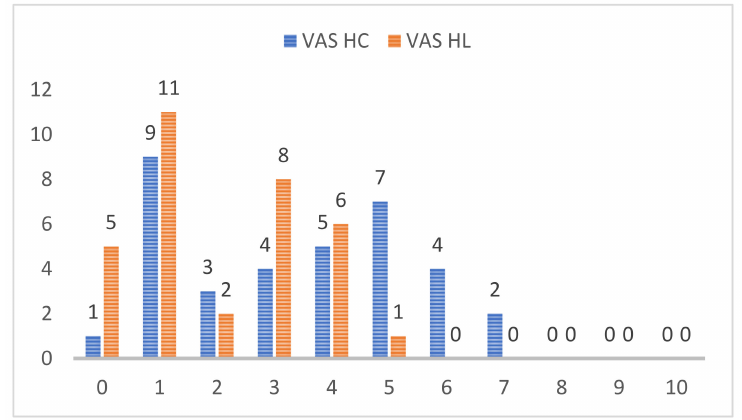
Figure 2. VAS score value reported by the subjects 24 h after the first activation. VAS score values given by the patients for the two half-arches, HL and HC, 3 h (T0), 24 h (T01), and 7 days (T02) after applying the orthodontic device are represented in Figure 3a, and those for 1 month after, at the first activation, in Figure 3b.